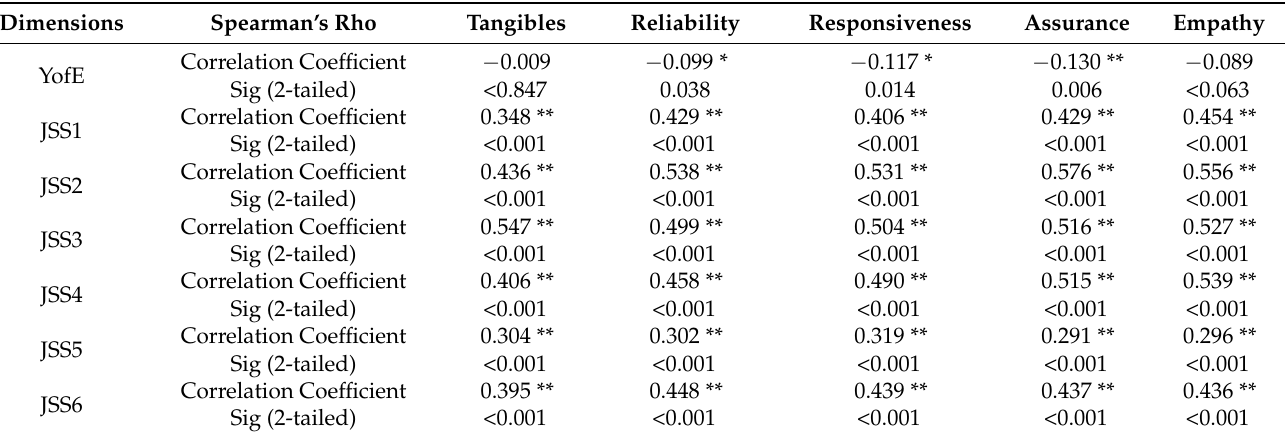
Table 8. Spearman’s Rho correlation coefficient results (a) among years of experience and quality dimensions and (b) job satisfaction subscales and quality